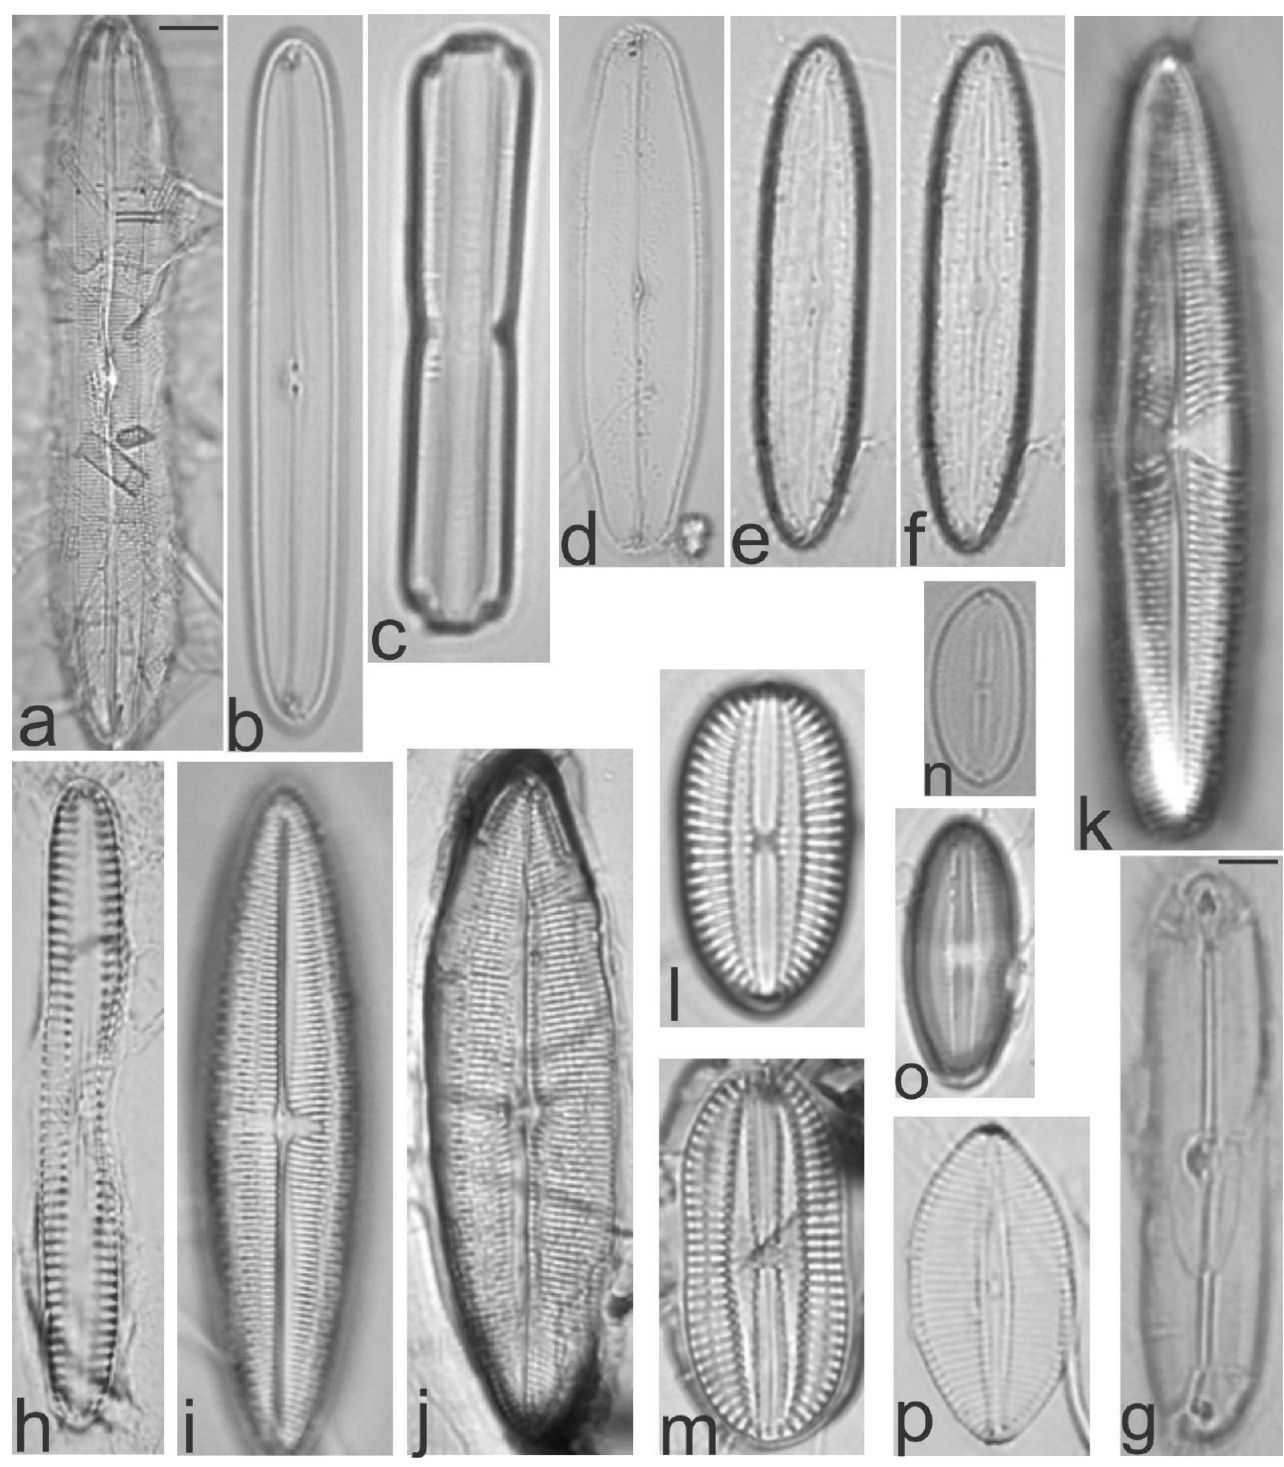
Figure 21. ( a ) Caloneis maxima var. bicuneata ; ( b , c ) C. linearis ; ( d ) Caloneis sp. 3; ( e , f ) Caloneis sp. 6; ( g ) C. liber ; ( h ) Biremis ambigua ; ( i ) Trachyneis aspera ; ( j ) T. velata ; ( k ) T. aspera var. oblonga ; ( l ) Diploneis papula ; ( m ) D. papula var. constricta ; ( n ) Diploneis sp. 2; ( o ) Diploneis cf. petersenii ; ( p ) D. litoralis var.? (lanceolate form). Scale bar = 10 μm.